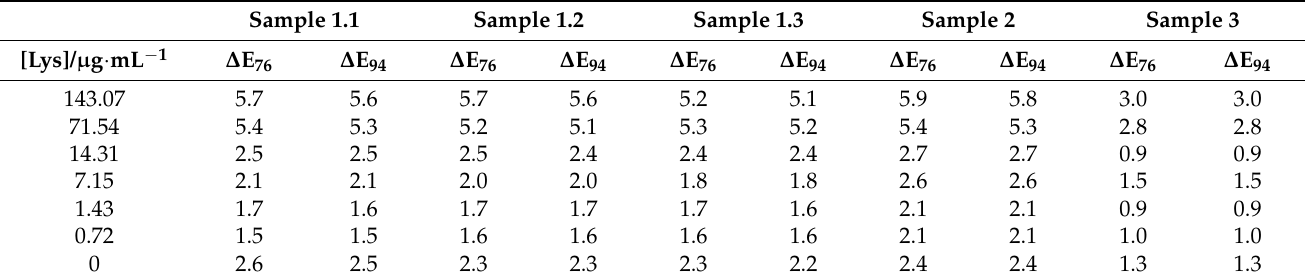
Table 1. ∆ E 76 and ∆ E 94 values obtained by direct comparation of the samples with the urine-free blank. Shaded values are over the JND threshold, with darker shaded ones being over the color difference